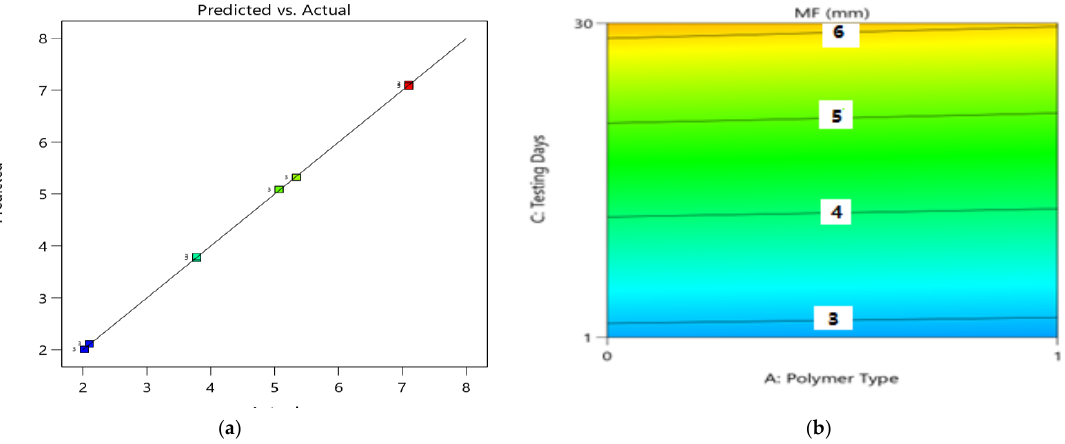
Figure 12. ( a ) Predicted vs. actual plot for MF (kN); ( b ) contour plot (2D) between the MF (mm) and three factors.